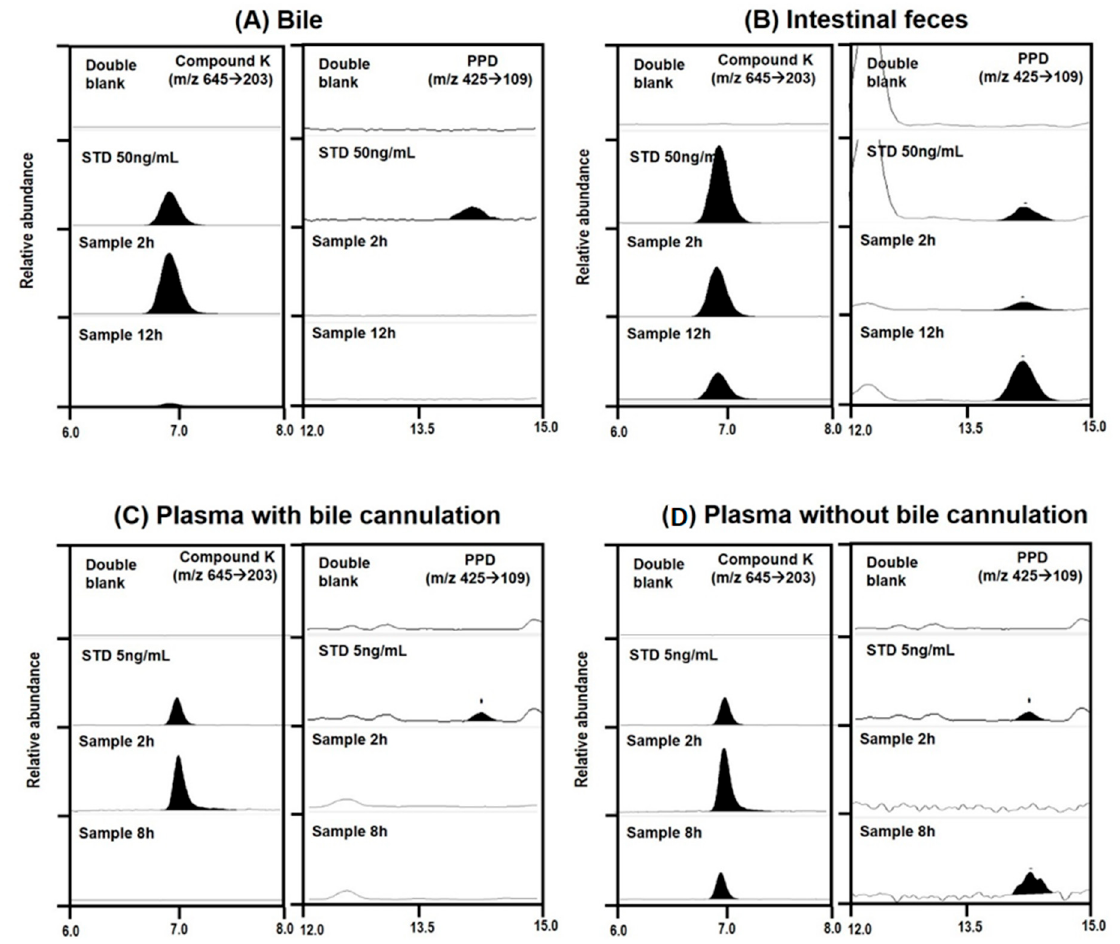
Figure 9. Representative multiple reaction monitoring chromatogram of compound K and PPD in ( A ) bile collected for 0–2 h and 2–12 h from bile cannulated rats, ( B ) intestinal feces samples collected from rats of non-bile cannulation at 2 or 12 h, ( C ) plasma samples taken at 2 and 8 h from bile cannulated rats, and ( D ) plasma samples taken at 2 and 8 h from rats of non-bile cannulation following intravenous injection of compound K (2 mg/kg).